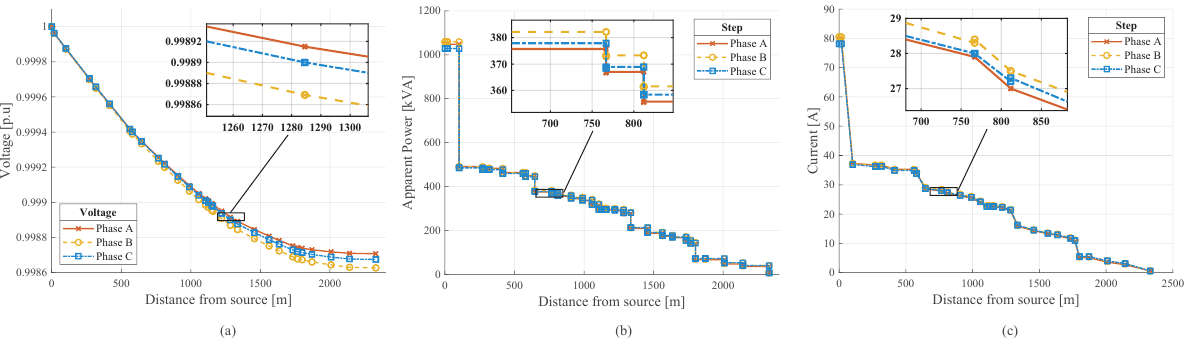
Figure 12. ( a – c ) Simulation results in